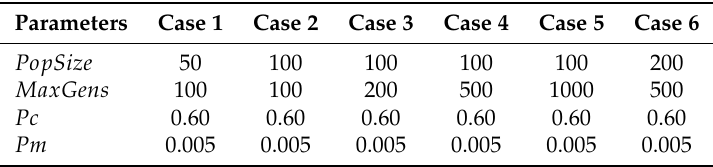
Table 5. Parameters of modified RCGA for each case.